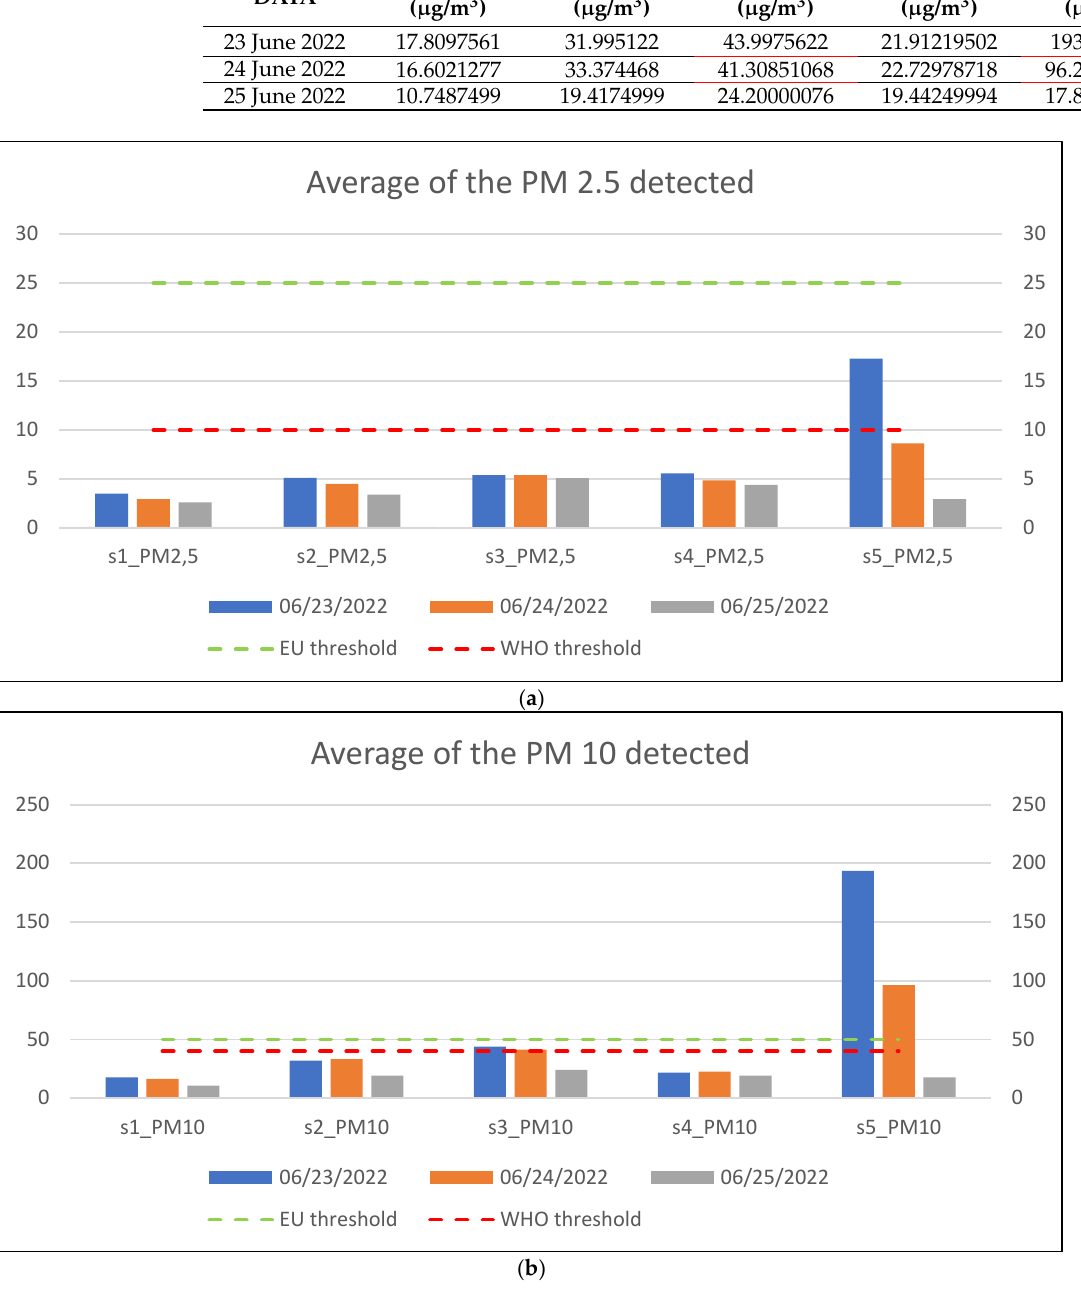
Figure 13. Average of the detected value of PM 2.5 ( a ) and PM 10 ( b ) at a standstill. The reported values give further confirmation of the fact that node 5, the node closest to the site of interest, is the one that detects the highest